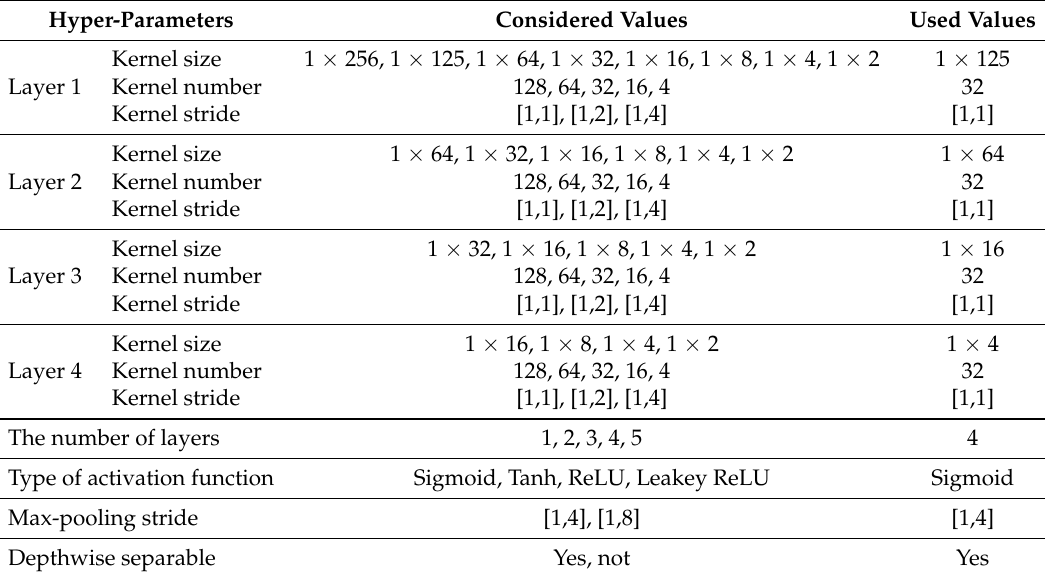
Table 1. Hyper-parameters of the